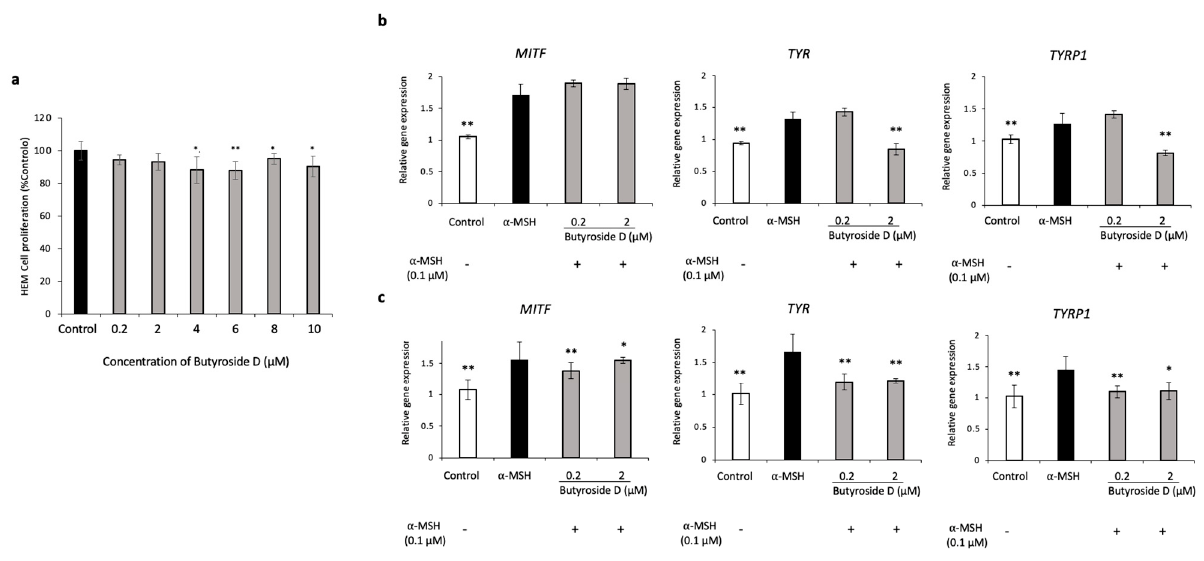
Figure 6. Validation of the effect of Butryoside D on the gene expression levels of melanogenesis- related genes using HEM cells. ( a ) MTT assay was performed to assess the cell proliferation of Butryoside D-treated HEM cells (0.2, 2, 4, 6, 8, and 10 µ M) and cells were used to validate the gene ex- pression levels of MITF, TYR, TYRP1, after ( b ) 24 h and ( c ) 48 h by quantitative RT-PCR, where melanin production was initially induced by α -MSH. Results are presented as mean ± SD ( n = 3). Statistical analysis was performed using one-way ANOVA where asterisks denote significant dif- ferences between α -MSH group and control or test groups being * p < 0.05 and ** p < 0.01.